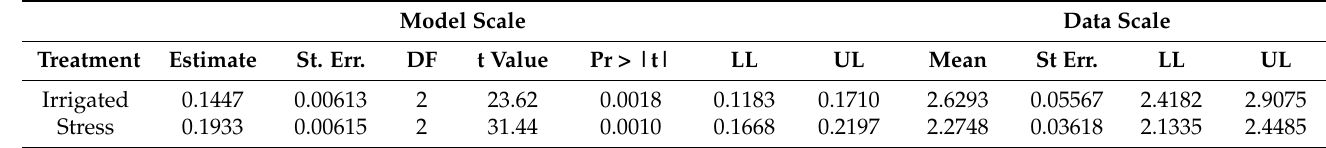
Table 4. Treatment Least Square Means.